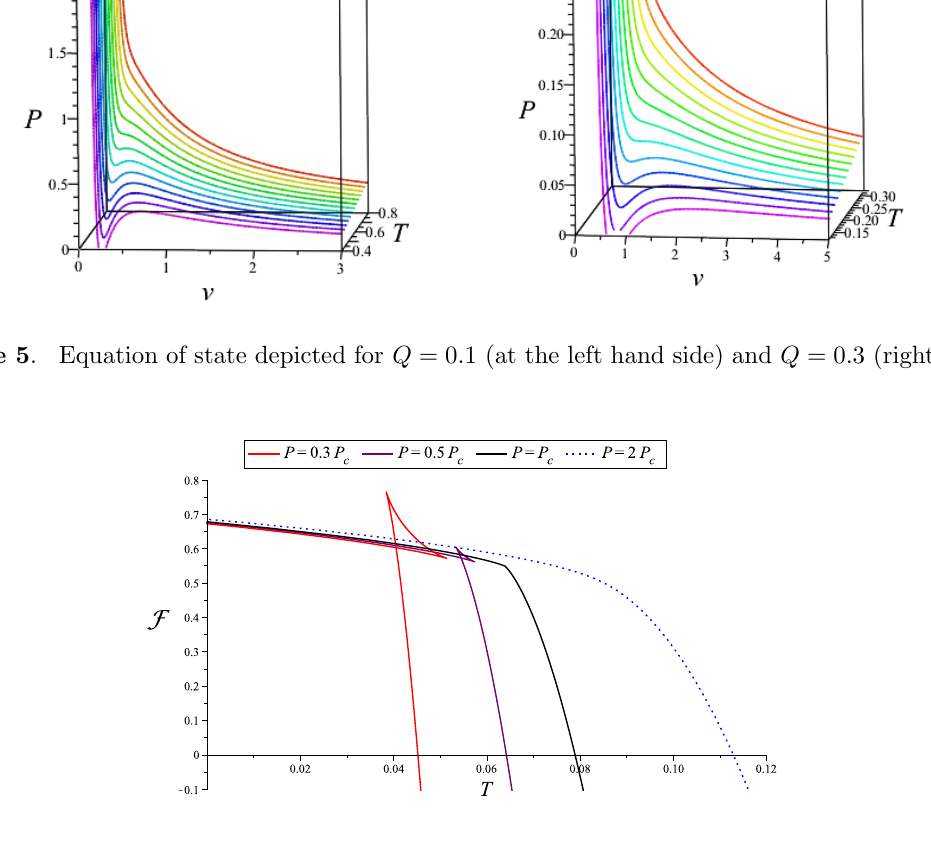
Figure 6 . Thermodynamic potential in canonical ensemble, for Q = 0 : 67. On the critical isobar P c (cid:25) 0 : 0074, the critical temperature is the temperature where the swallowtail ends, T c (cid:25) 0 : 064, at F c (cid:25) 0 : 547. There is a small-large black hole (cid:12)rst-order phase transition for T < T c . black hole. The critical compresibility factor Z